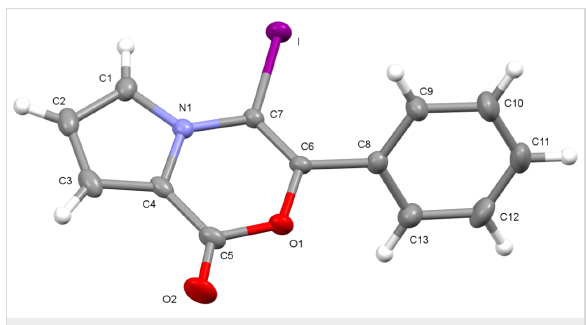
Figure 7: Single-crystal X-ray structure of 19c shown with 40% proba- bility displacement ellipsoids.